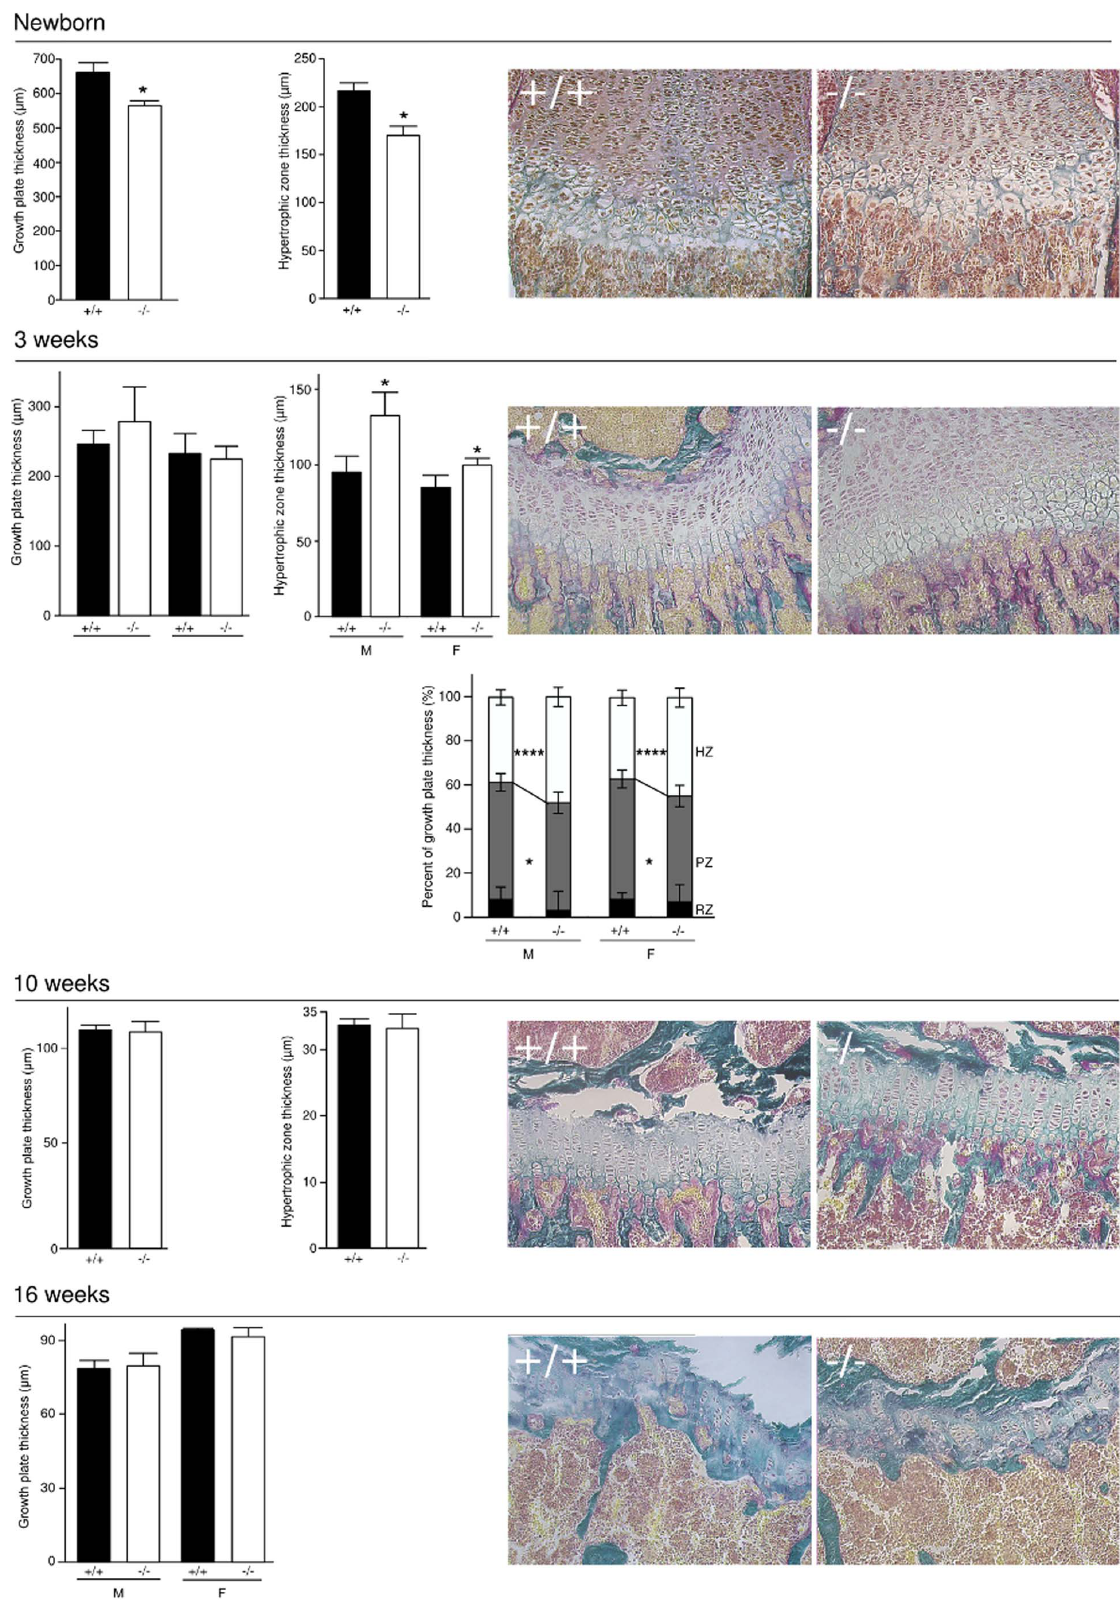
Figure 4. Growth plate kinetics of newborn, 3 week old, 10 and 16 week old BSP + / + and BSP 2 / 2 mice. Data are Mean 6 SEM of N=7 to 8 newborn and 4 to 6 adult mice; *:p , 0.05, **:p , 0.001 vs BSP + / + Mann-Whitney U Test. Micrographs of the growth plate in the distal femur of BSP + / + and BSP 2 / 2 newborn and 3, 10 and 16 week old mice. doi:10.1371/journal.pone.0095144.g004 PLOS ONE |